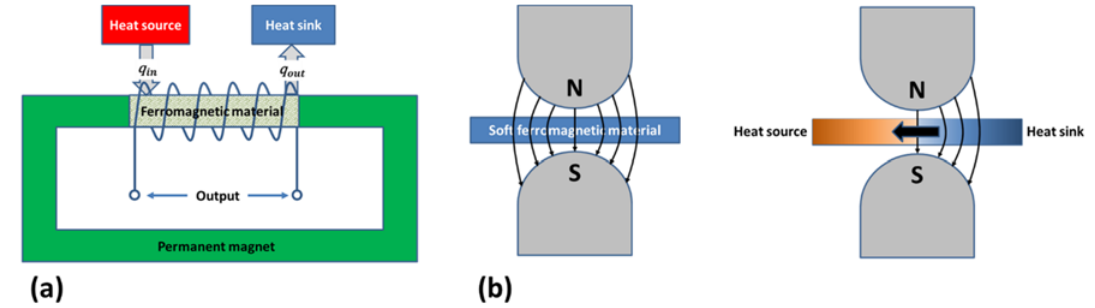
Figure 17. The working mechanism of active ( a ) and passive ( b ) thermomagnetic energy conversion devices. Adapted from [142], with permission from © 2018 Elsevier.